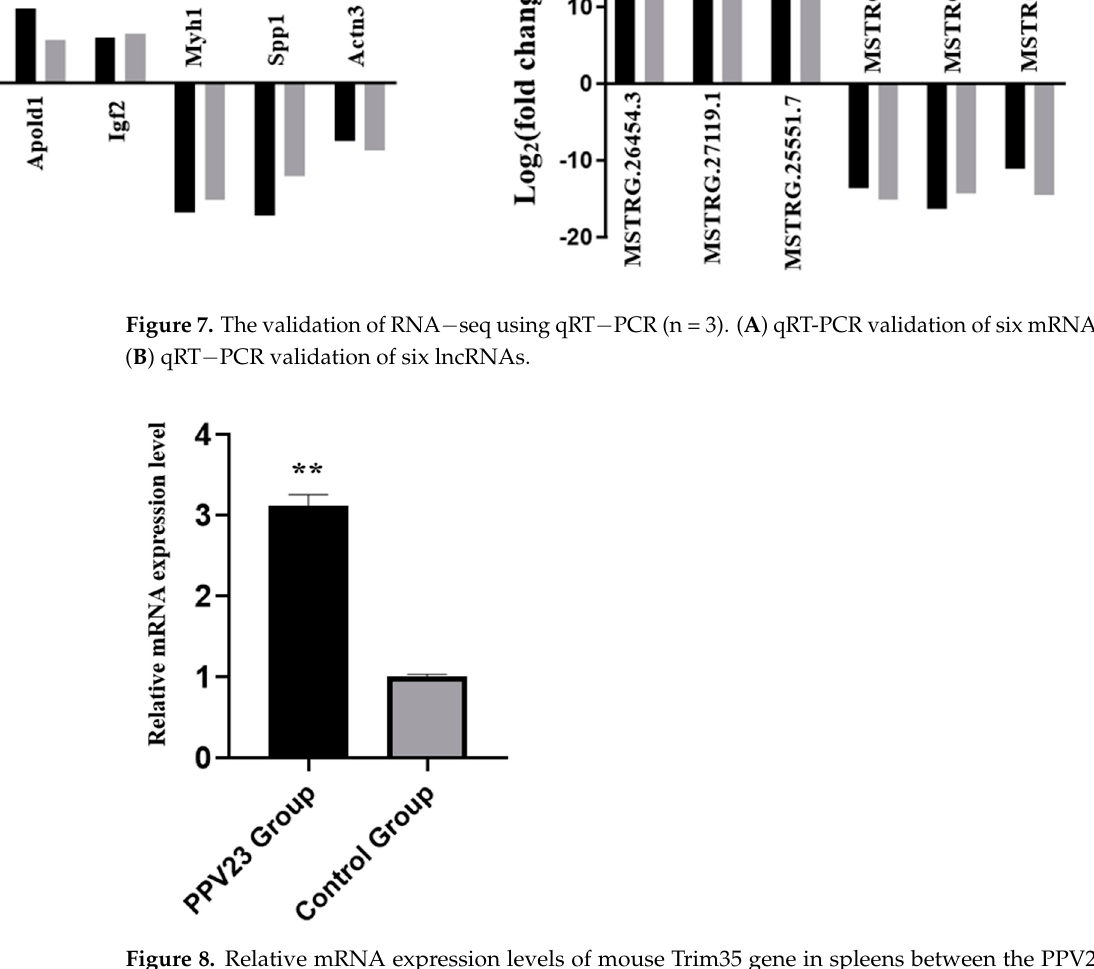
Figure 8. Relative mRNA expression levels of mouse Trim35 gene in spleens between the PPV23 treatment group and the control group (n = 3). ** indicates significant differences ( p <